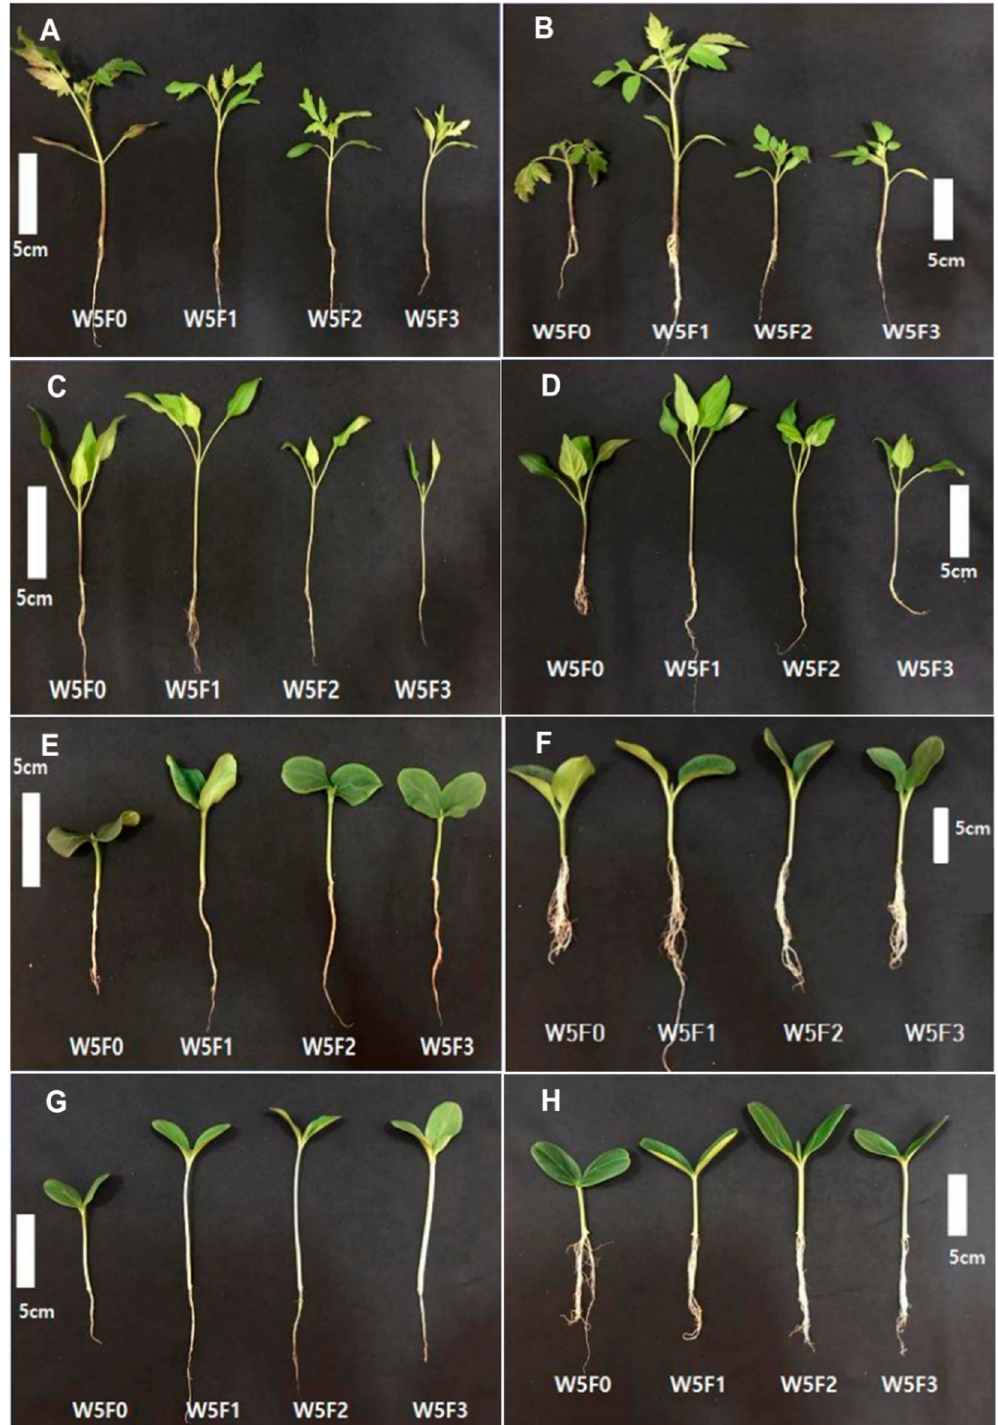
Figure 2. Seedlings of tomato “Dotaerangdia” ( A ) and “B-blocking” ( B ) at 14 days after sowing (DAS), red pepper “Shinhong” ( C ) and “Tantan” ( D ) at 14 DAS, cucumber ( E ) and gourd ( F ) at 7 DAS and watermelon ( G ) and bottle gourd ( H ) at 9 DAS under the different supplemental far-red-enriched LED treatments. The treatments were cool white LED:far-red LED at ratios of 5:0, 5:1, 5:2 and 5:3, or W5F0, W5F1, W5F2 and W5F3, respectively.